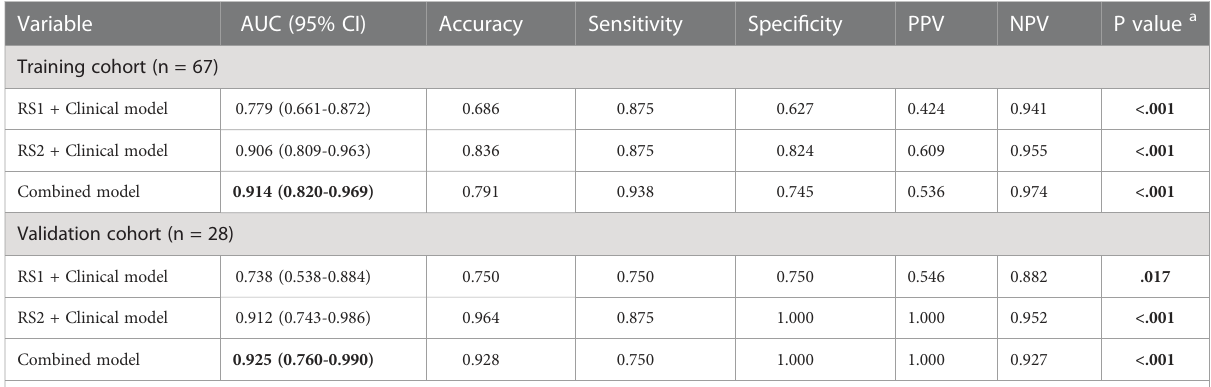
TABLE 4 Performance of combined model combining multi-period image with clinical information and the model combining single-period images with clinical information.